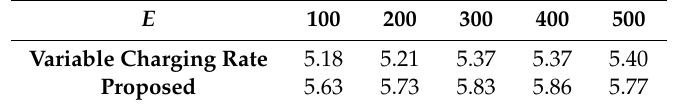
Table 7. Comparison of Average Computation Time (Seconds) for Algorithms under No DR Event.